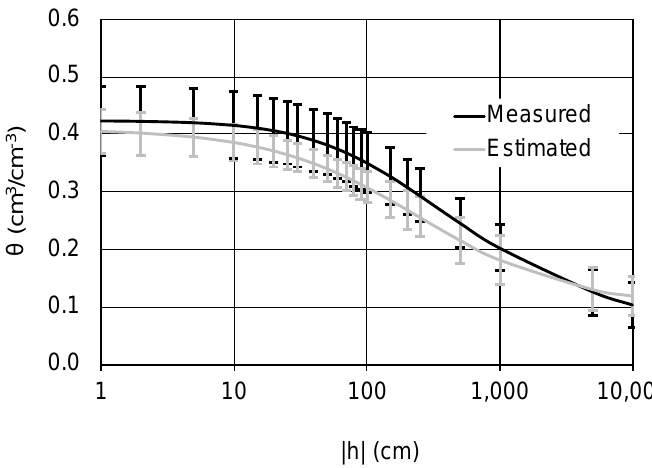
Figure 3. Average and error bars (standard deviation) of both measured (black lines) and estimated (grey lines) SWRCs.